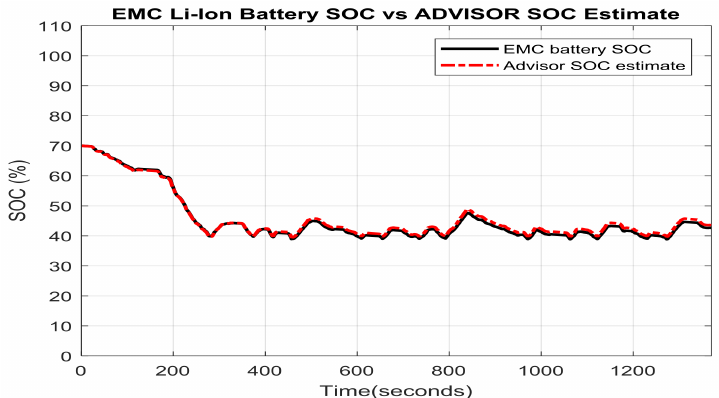
Figure 6. The 2RC EMC Li-Ion battery SOC versus ADVISOR SOC estimate in MATLAB simulation environment.